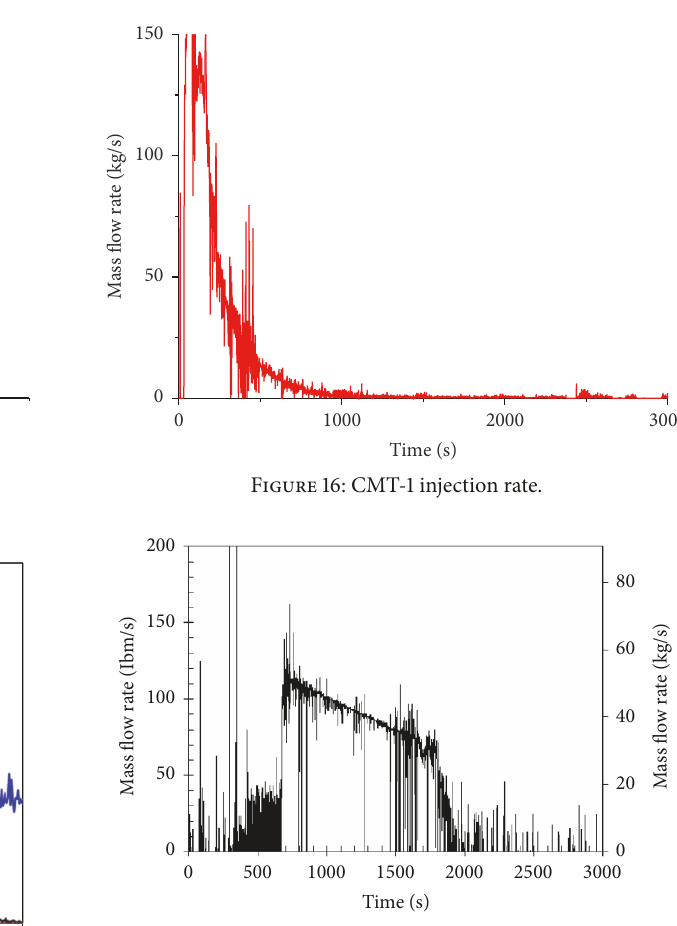
Figure 17: 10-inch Cold Leg Break: CMT-1 (NOTRUMP code) [7].